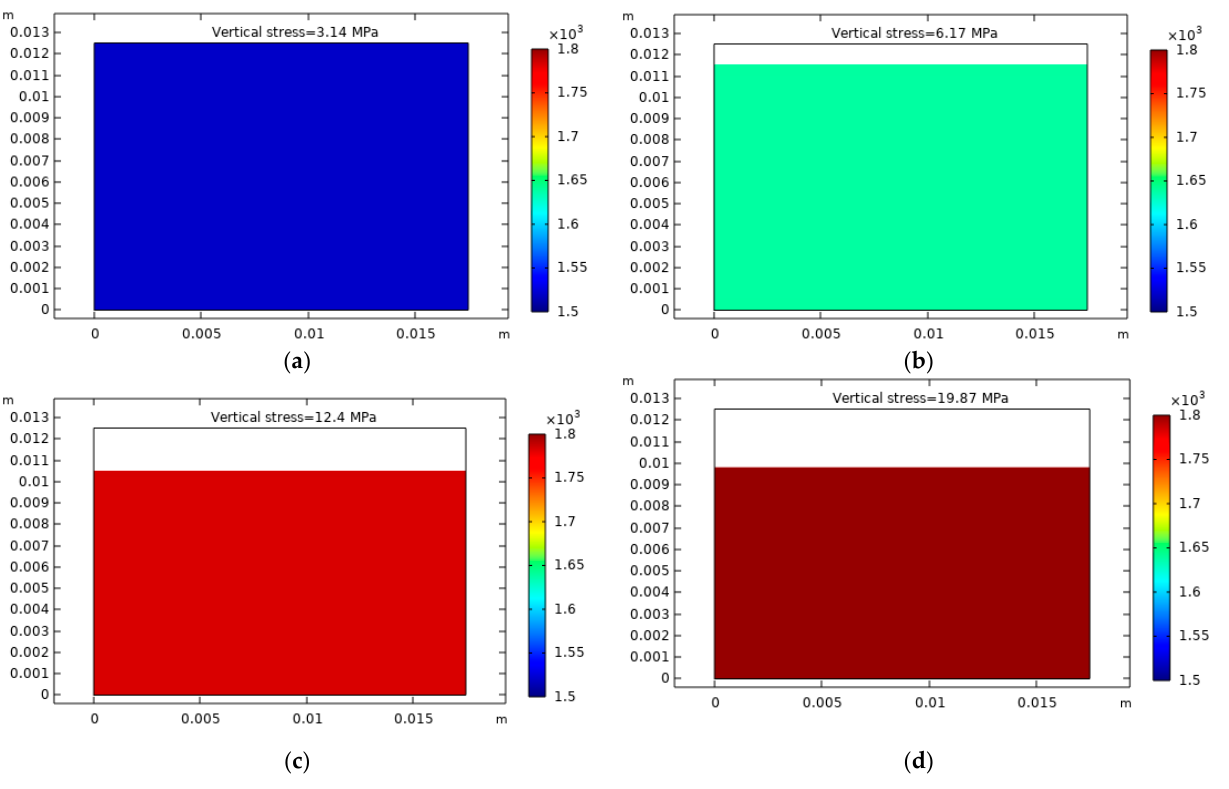
Figure 8. Dry density distribution at different vertical stress (( a ) σ V = 3.14 MPa, ( b ) σ V = 7.97 MPa, ( c ) σ V = 15.97 MPa, ( d ) σ V = 19.87 MPa) (Path AB’C’, compression stage